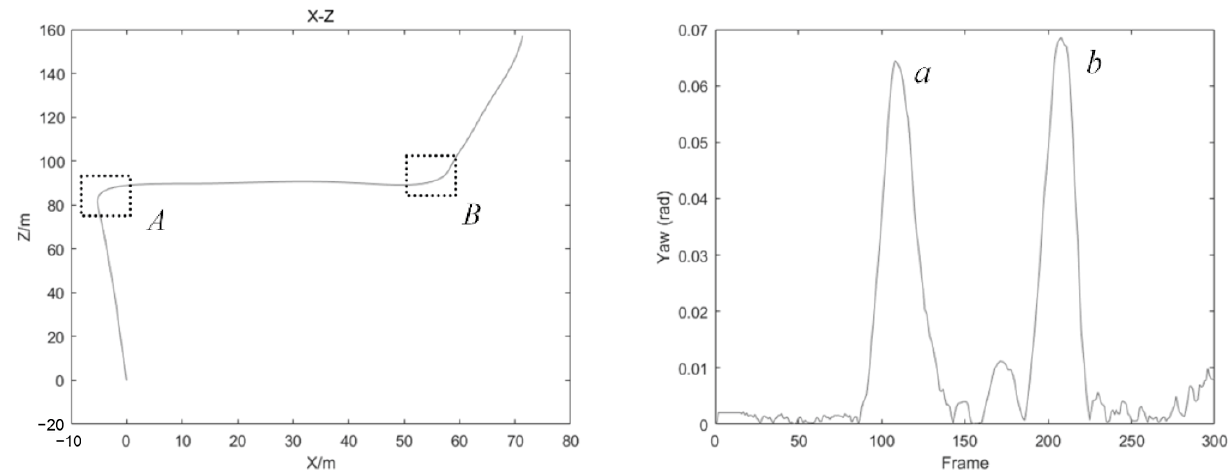
Figure 6. The veers A and B in the trajectory ( left ) correspond to the peaks a and b in the yaw angle diagram ( right ), respectively.